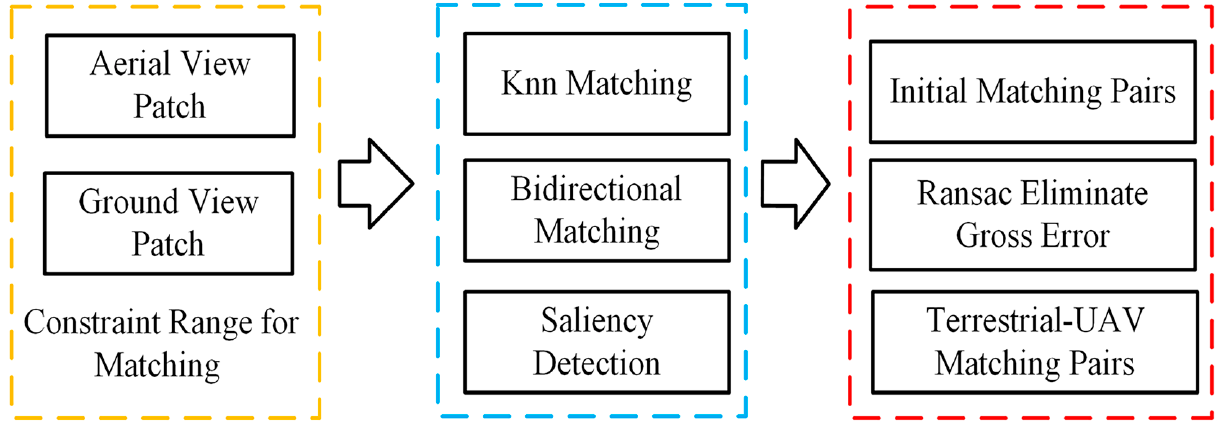
Figure 6. Flowchart of terrestrial–aerial image matching.